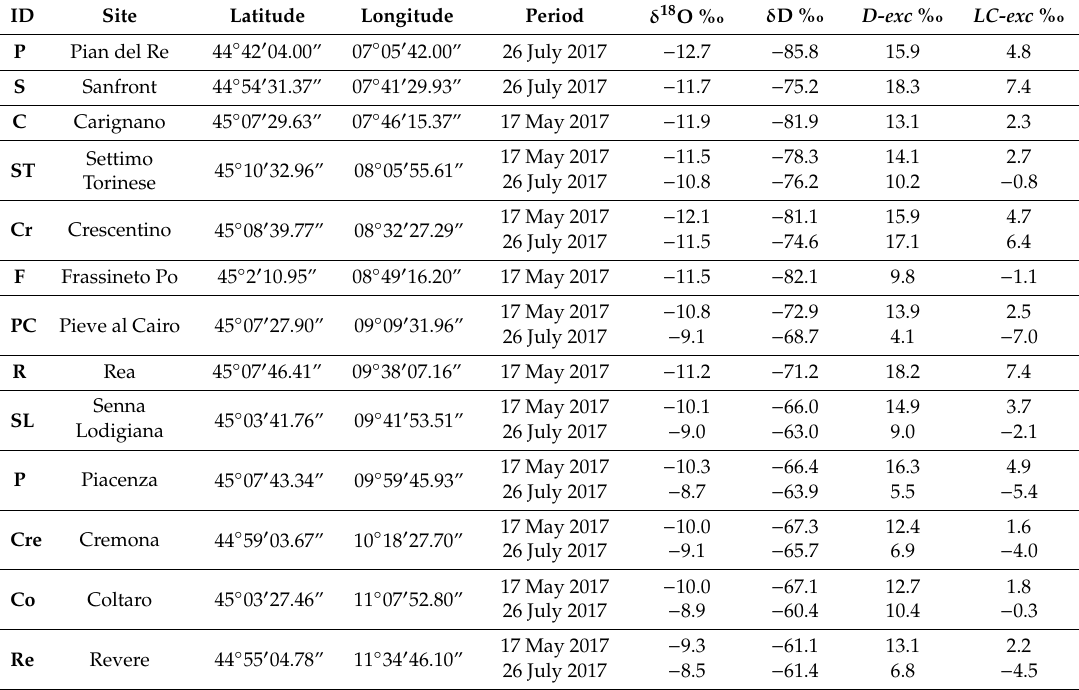
Table 1. Hydrogen and oxygen isotopic composition and derivate parameters D-exc and LC-exc of the Po river water collected in the year 2017 (May and July). Coordinates and abbreviations of the sampling sites (cf. Figure 1) are also reported.